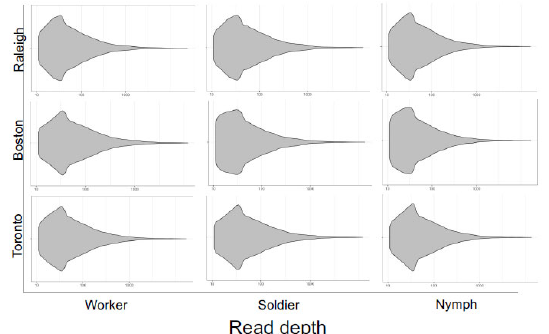
Figure 3. Read depth of high-quality (depth > 10) SNVs extracted from variant call files for three termite castes (worker, soldier, nymph) sampled from three populations (Raleigh, Boston, Toronto). The overall profiles of read depth coverage are similar between libraries, suggesting consistently high qualities.